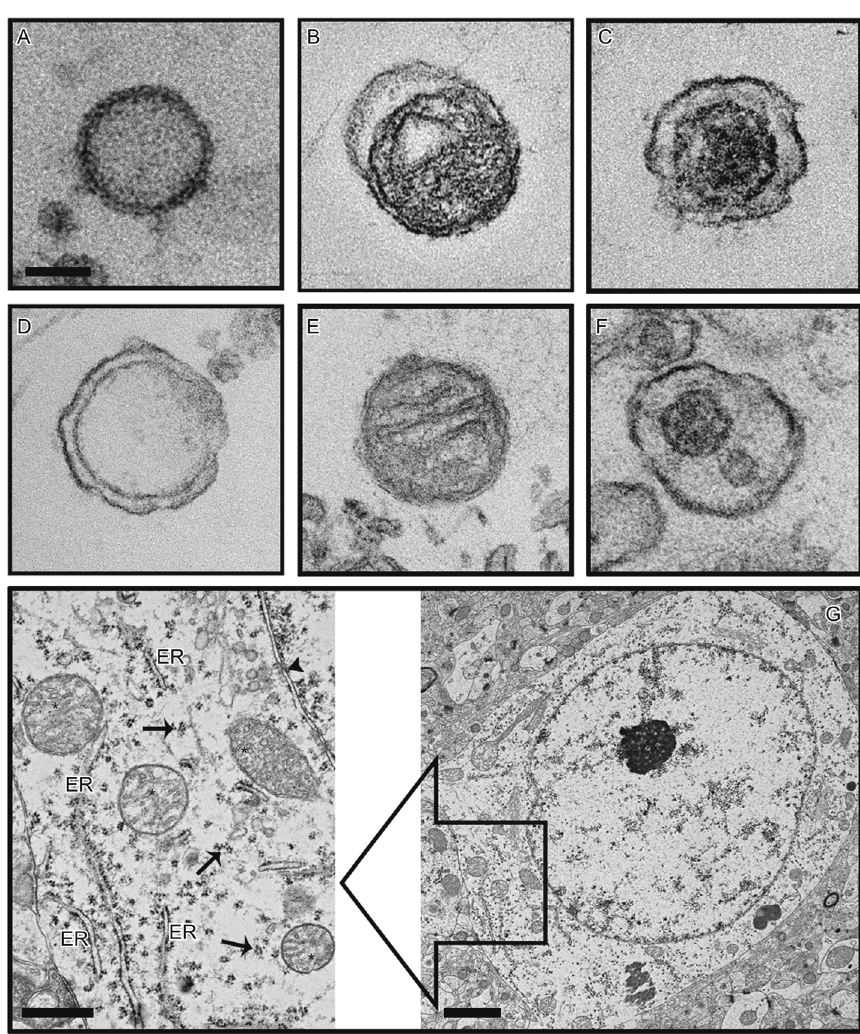
Figure 1. mtMPs were detected in plasma samples from FPI mice. TEM images of mitochondria-free MPs (A), naked mitochondria (B), and mitochondria-embedded BDMP (C*: mitochondria) detected in plasma samples of FPI mice. (D) Mitochondria- lacking MPs, mitochondria (E), and mitochondria-embedded membrane microparticles (F*: mitochondria) from BDMPs produced in vitro . (G) The section of a non-injured mouse brain shows a dense perinuclear accumulation of mitochondria (left, arrowhead: nuclear membrane). A locally enlarged image further shows mitochondria (*), endoplasmic reticulum (ER) and membrane-bound, and free polyribosomes